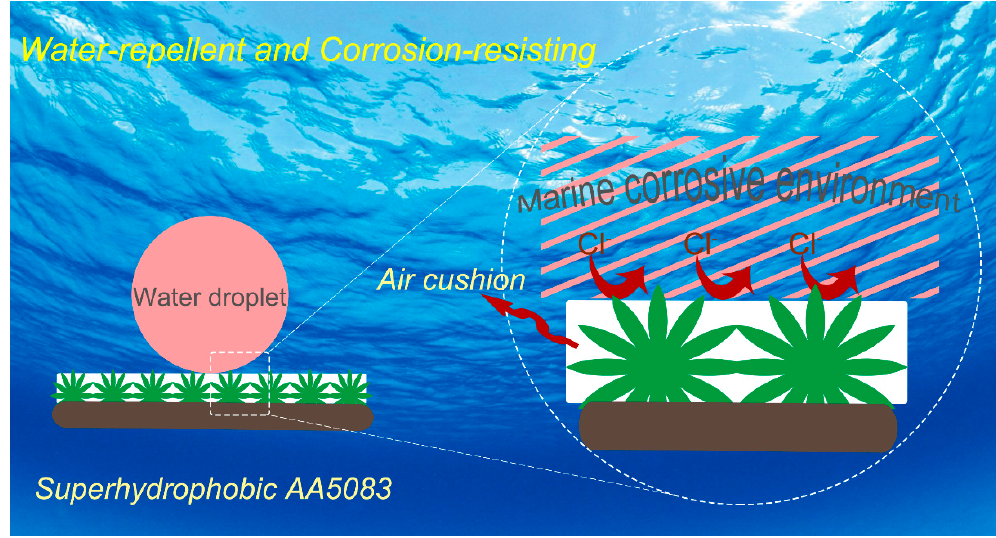
Figure 9. Anticorrosion mechanism of the as-prepared superhydrophobic AA5083.